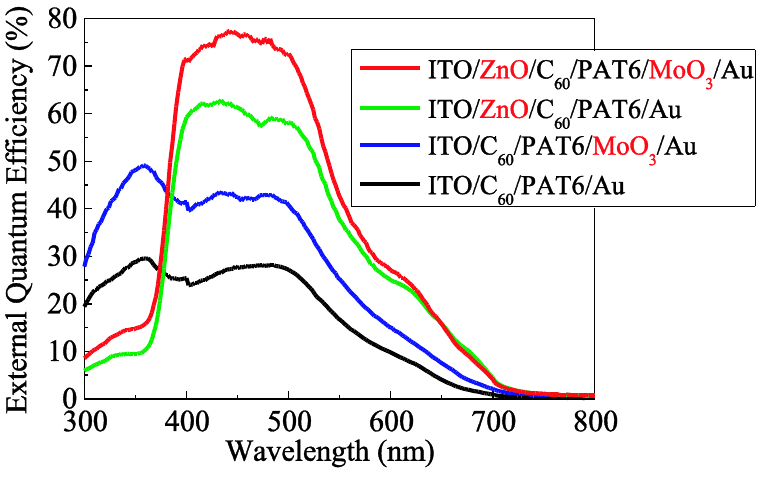
and ZnO buffer layers (6 nm and 50 nm, 3